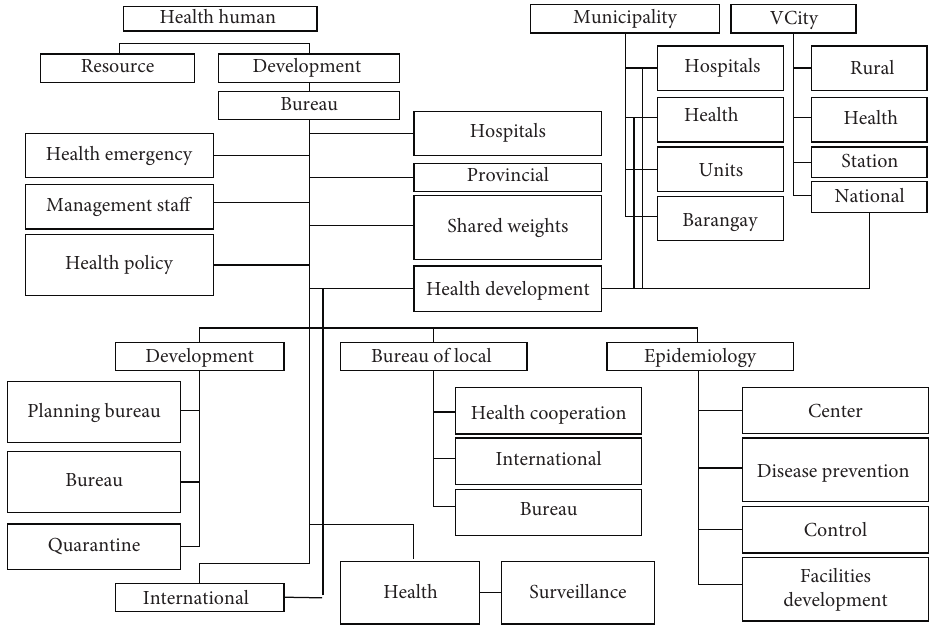
Figure 3: Multigrained information interaction within an